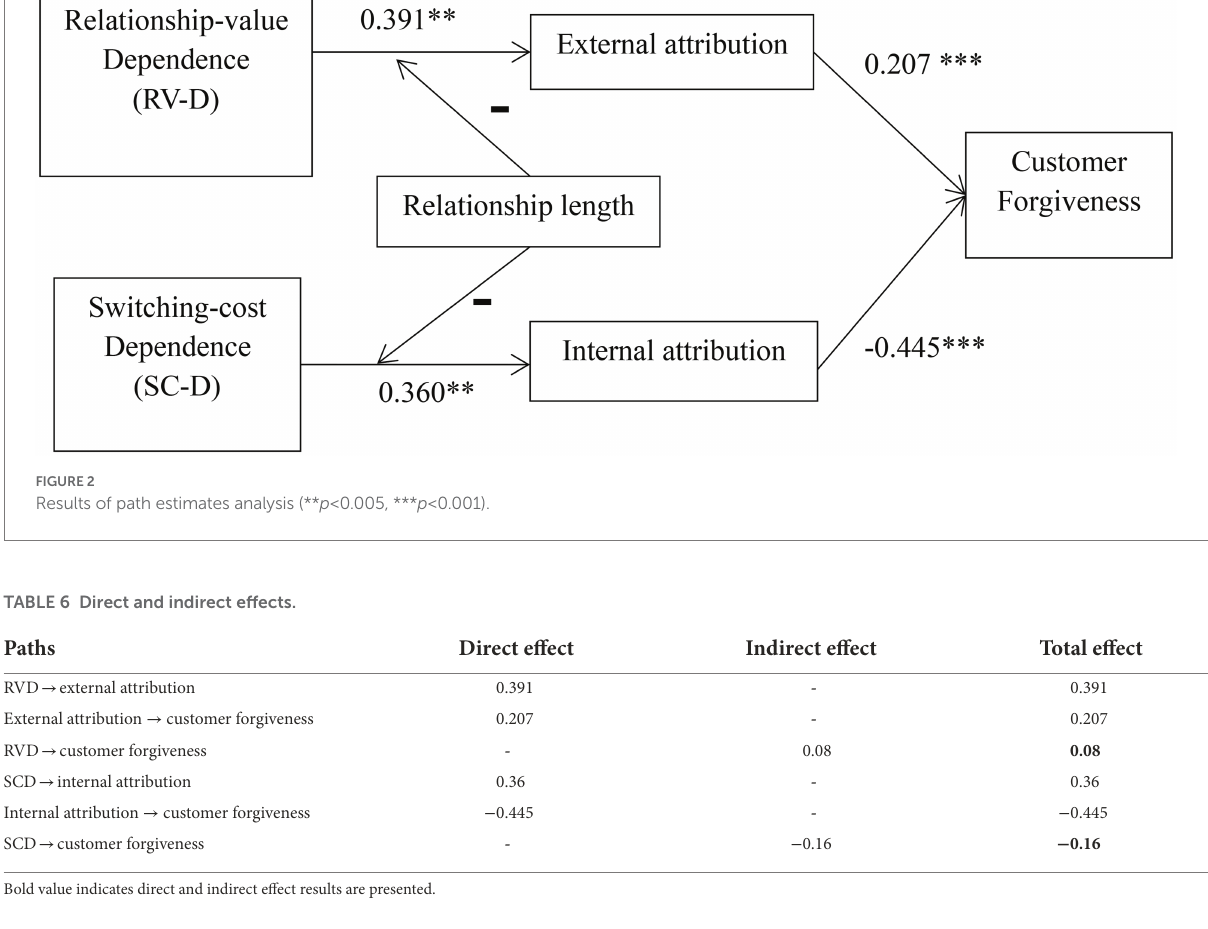
TABLE 7 Summary of multi-group